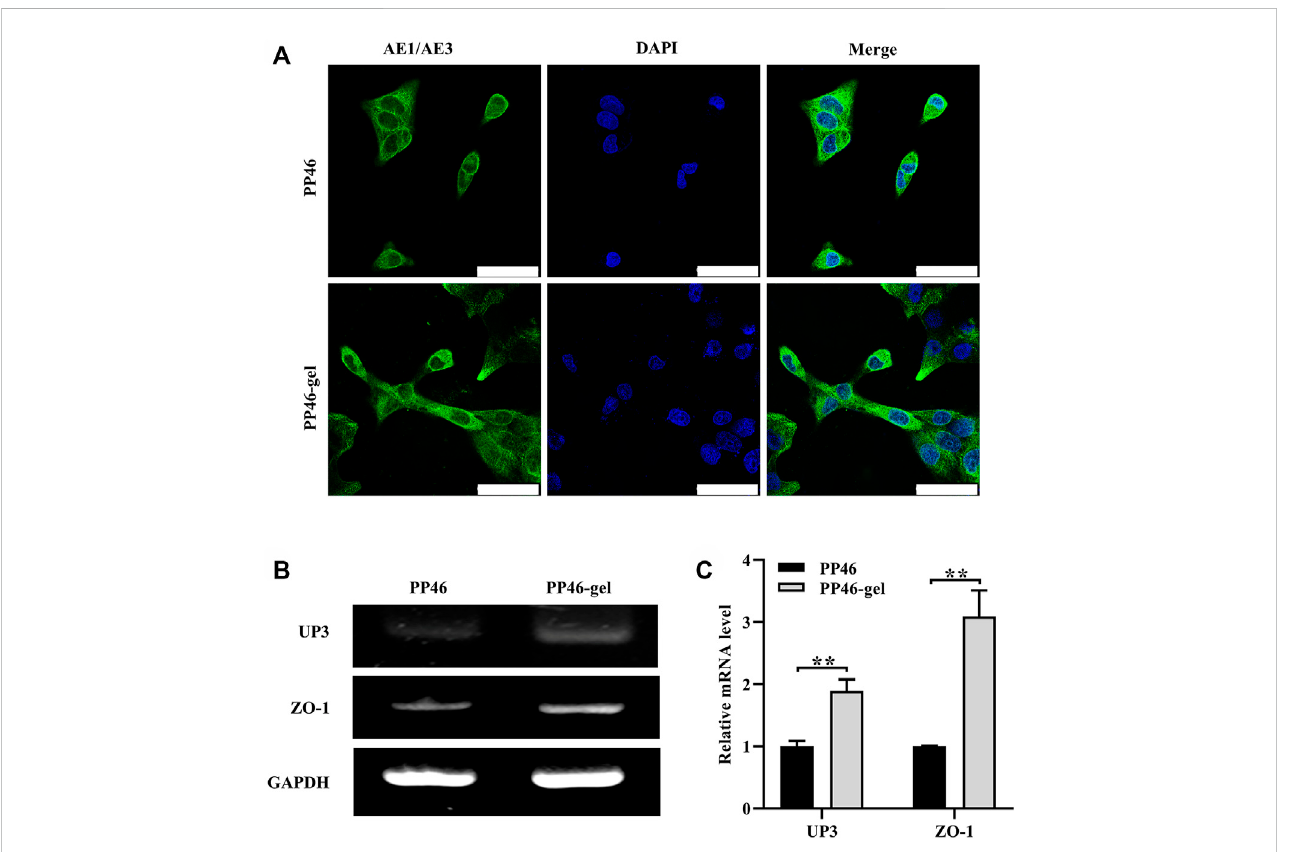
FIGURE 6 Phenotypic expressionofHUCsonscaffoldsPP46andPP46-gel. (A) Epithelial phenotype withanti-cytokeratin AE1/AE3astheprimaryantibody(green). The nuclei were stained with DAPI and displayed as blue. Cells were cultured for 7 days. Scale bar, 50 μ m. (B) Analysis of UP3 and ZO-1 mRNA tested by RT- PCR. (C) Quantitative analysis of UP3 and ZO-1. Data are presented as mean ± SD (** p <